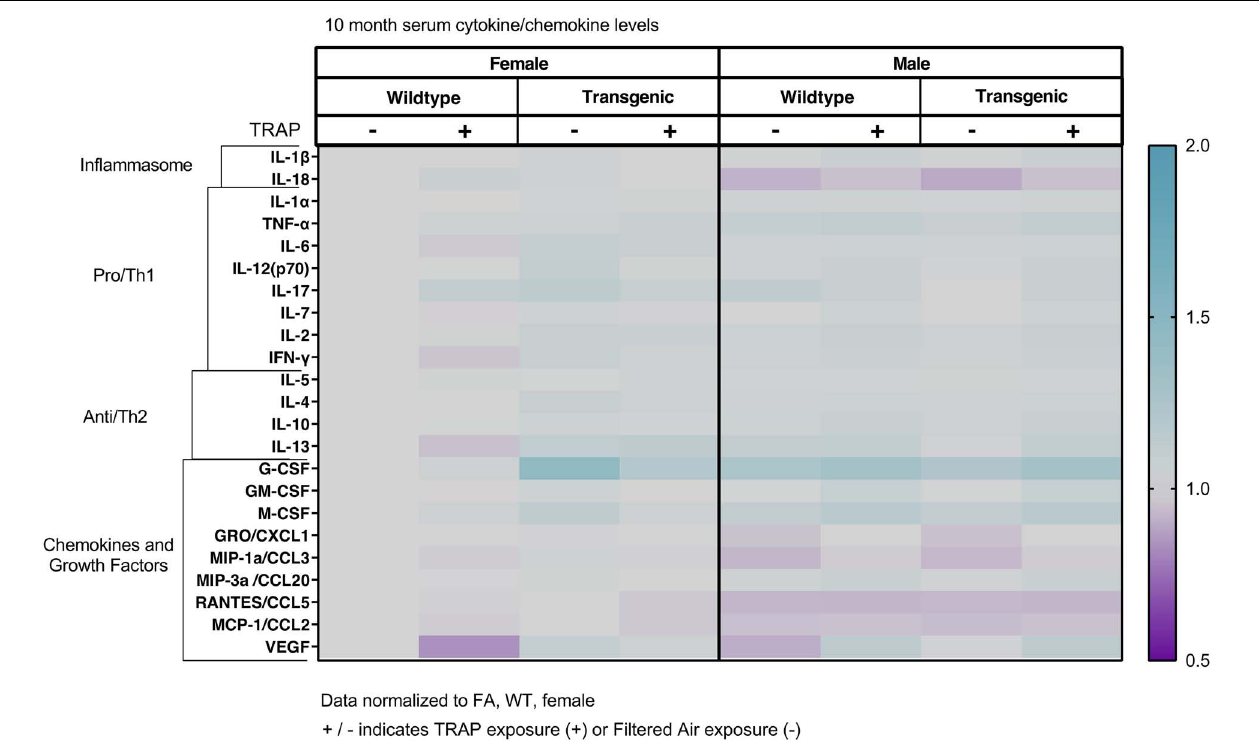
FIGURE 4 | Heat map representation of serum cytokine, chemokine, and growth factor changes in response to TRAP in 10-month old TgF344-AD and WT rats. Serum levels of cytokines and growth factors in TgF344-AD and WT rats exposed to FA or TRAP for 9 months were analyzed using multiplex technology. For each analyte, individual values were normalized to the mean level of that same analyte in sera from female FA WT animals. Purple indicates normalized protein levels < 1.0; turquoise indicates normalized protein levels > 1.0. ± indicates exposure with + identifying TRAP-exposed animals; - indicating FA-exposed animals; n = 4–5 animals per group (duplicate samples were analyzed for each animal). Non-normalized cytokine values for female FA WT animals are provided in Supplementary Table 1 .